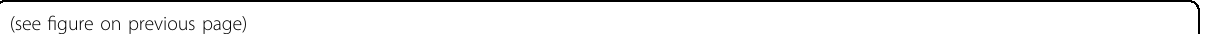
Fig. 4 Primary MLL5 transduced APL blasts (GFP + cells) exhibited increased cell proliferation and granulocytic differentiation in vitro and in vivo. A Representative images of May-Grünwald-Giemsa-stained cytospins of transduced primary APL blasts (pMEG, and pMEG-MLL5) treated 8 days with ATRA (1 µM) and DMSO control (vehicle, 0.01%). B Fluorescence-activated cell sorting (FACS) immunophenotype of CD11b staining of transduced APL blasts with MLL5 or empty vector and C percentage of CD11b + cells in transduced primary blasts after 8 days of ATRA (1 μ M) treatment as the standard stimulus for differentiation. Data were expressed as mean ± standard error of the mean. D Schematic representation of cell proliferation assay based on GFP expression in primary APL cells transduced with MLL5 and the empty vector control (pMEG). Graphic bars represent the number of GFP + cells inside the bulk of transduced primary APL blasts during 14 days of culture. Data were expressed as mean ± standard error of the mean. Overview of the mouse xenograft for APL. E Schematic representation of the generation of the xenograft mouse model for APL engraftment using NSGS mice. Representative FACS phenotype from a primary murine bone marrow transplanted with human transduced APL blasts with the empty vector ( F ) or the MLL5 gene ( G ) at sacri fi ce. APL blasts and mature myeloid committed cells were analyzed by fl ow cytometry using markers against CD117, CD33 and CD11b as indicated (inside the population huCD45 + and GFP + ). Scatter plots showing engraftment of donor human CD45 + cells (regardless the GFP expression), human CD45 + GFP + cells and human CD45 + GFP + CD11b + cells in bone marrow ( H ), I spleen (percentual of engraftment and spleen weight) and J liver of transplanted mice at sacri fi ce. Data were expressed as median values. Ex vivo analysis of transduced APL blasts reinforces in vitro fi ndings. L Incubation of bone marrow sorted APL blasts cells (GFP + CD45 + CD117 + CD33 + ) from pMEG/MLL5 engrafted mice, with ATRA plus ATO (1 μ M each) led to increased induction of apoptosis over the course of 72 h in empty vector cells. Percentage of CD11b + cells in sorted blasts from murine BM isolated from engrafted pMEG and MLL5 mice, after 8 days of ATRA alone or in combination with ATO (1 μ M each) treatment as the standard stimulus for differentiation. Data were expressed as mean ± standard error of the mean. M Summary results from APL xenograft murine model to study the role of MLL5 in APL. * P < 0.05. ** P < 0.01. *** P < 0.001. NS indicates not signi fi